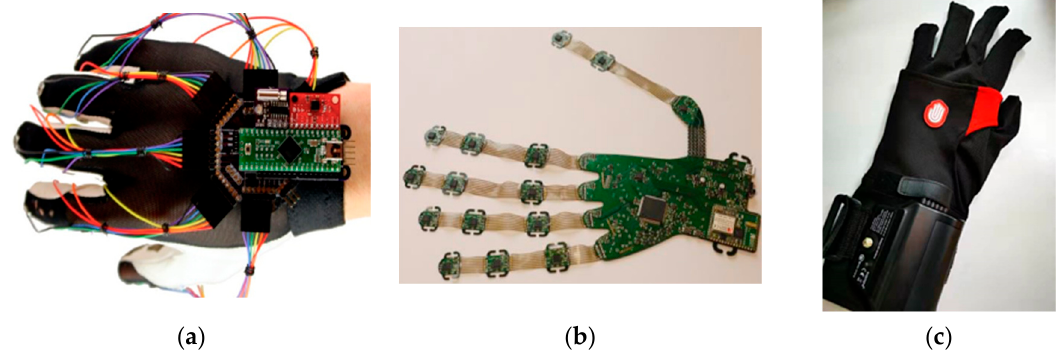
Figure 5. Data gloves made with inertial measurement units (IMUs) or magnetic sensors. ( a ) Keyglove Prototype E [48]. ( b ) IMUs combined with stretchable materials [44]. ( c ) Noitom Hi5 VR glove [49].